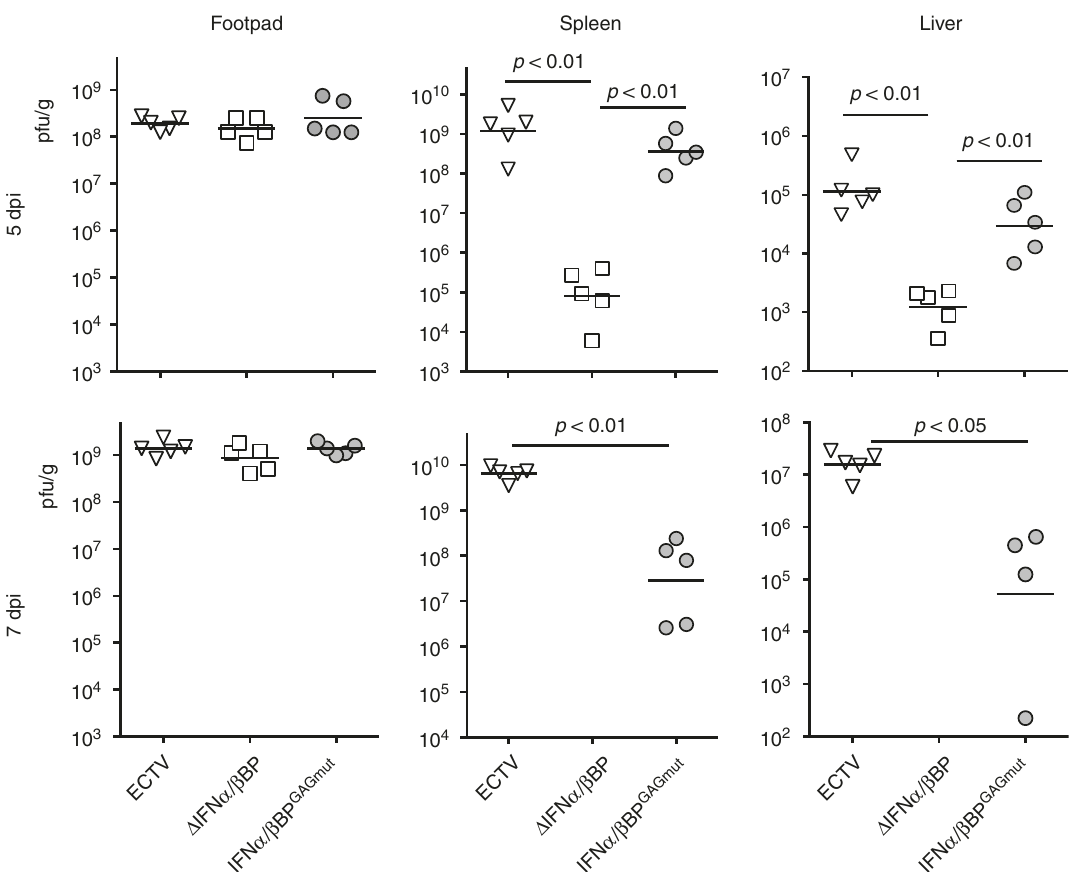
Fig. 6 Virus dissemination in mice infected with ECTV mutants. Five Balb/c mice per condition were s.c. inoculated in the footpad with 10 3 pfu of the indicated ECTV recombinants and virus titres in footpad, spleen and liver were determined by plaque assay at 5 and 7 dpi. Independent virus titres from each infected animal and the mean value are shown. Data below the detection limit of the assay (10 2 pfu/mg) are not depicted. Statistical signi fi cance indicated after Mann – Whitney test, assuming 0 value for undetectable viral